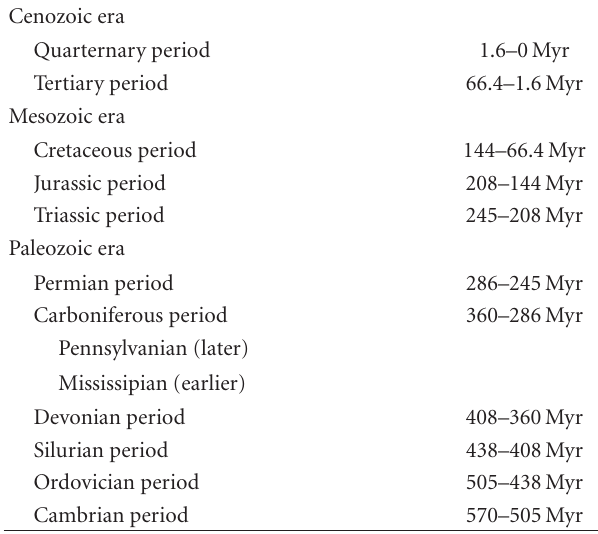
Table 1: Table of geological timescales used in this paper. The nomenclature and dates are based on those in [12,